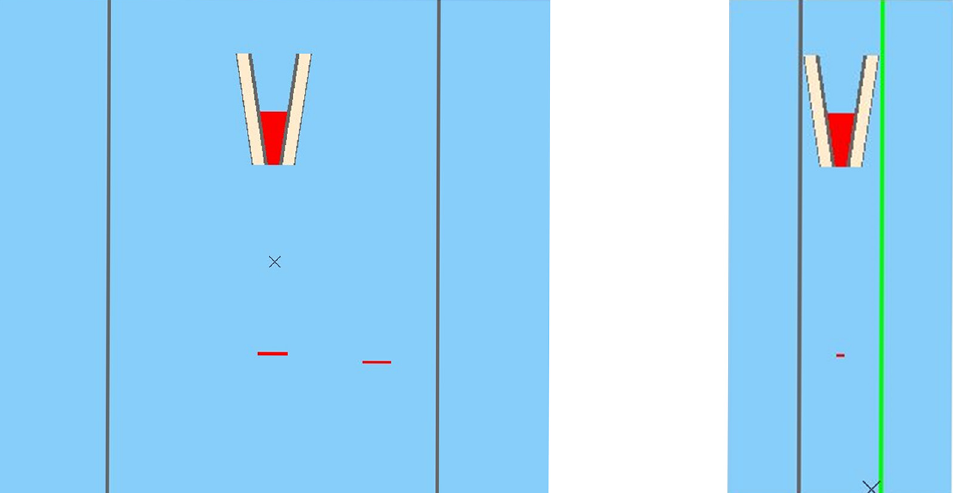
Fig. 1. Visualisation of sections of the glove box model obtained with TRIPOLI-4 ® viewer: ( y , z ) plane on the left, and ( x , z ) plane on the right. The red cone represents the mixed oxide in the jar, the red rectangle in the centre the pressing table and the cross at the bottom right the corner full of dust, just behind the Kyowa Glass (in green in the fi